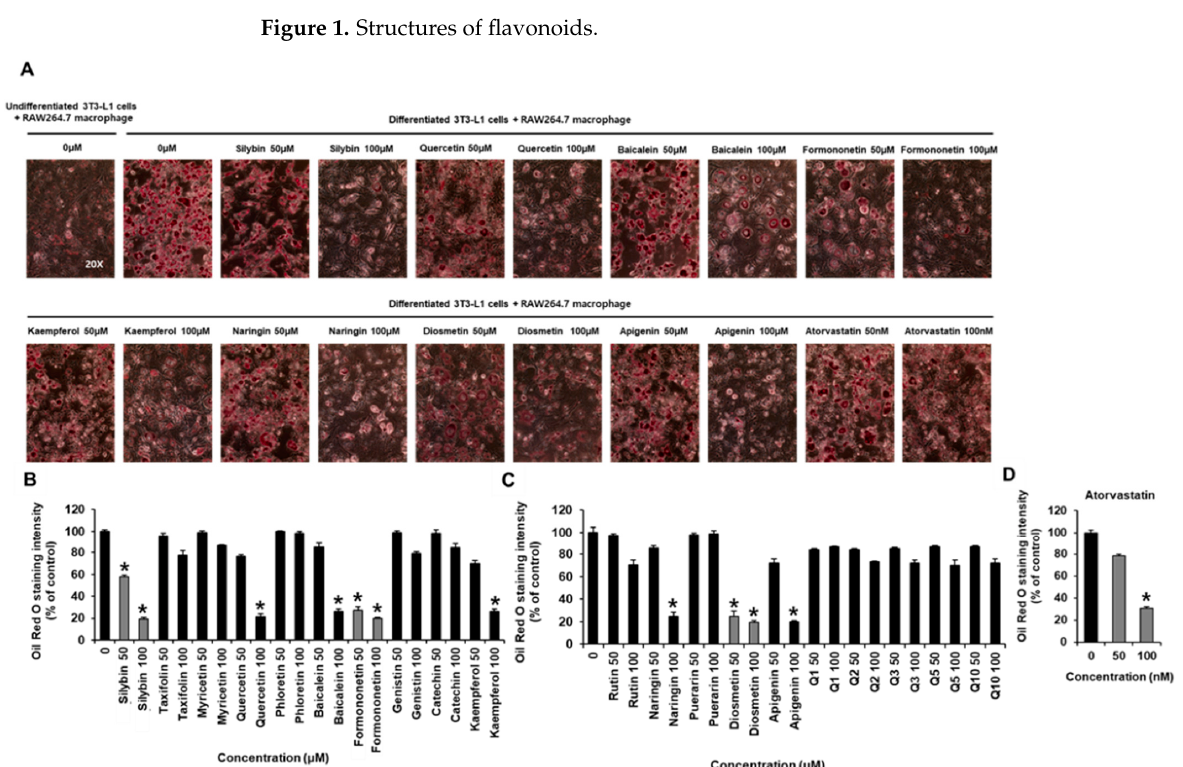
Figure 2. Inhibitory effects of flavonoids and atorvastatin (positive control) on lipid accumulation in the co-cultures of 3T3-L1 and RAW264.7 cells. ( A ) Images and ( B – D ) quantification of the Oil Red O stained droplets (absorbance at 490 nm) of the co-cultures of 3T3-L1 and RAW264.7 cells treated with the indicated concentration of flavonoids. In individual experiments, each treatment condition was set up in quadruplicate, and each experiment was repeated three times independently (* p < 0.05 compared to untreated cells, Kruskal–Wallis non-parametric test). Data are represented as the mean ± SEM.